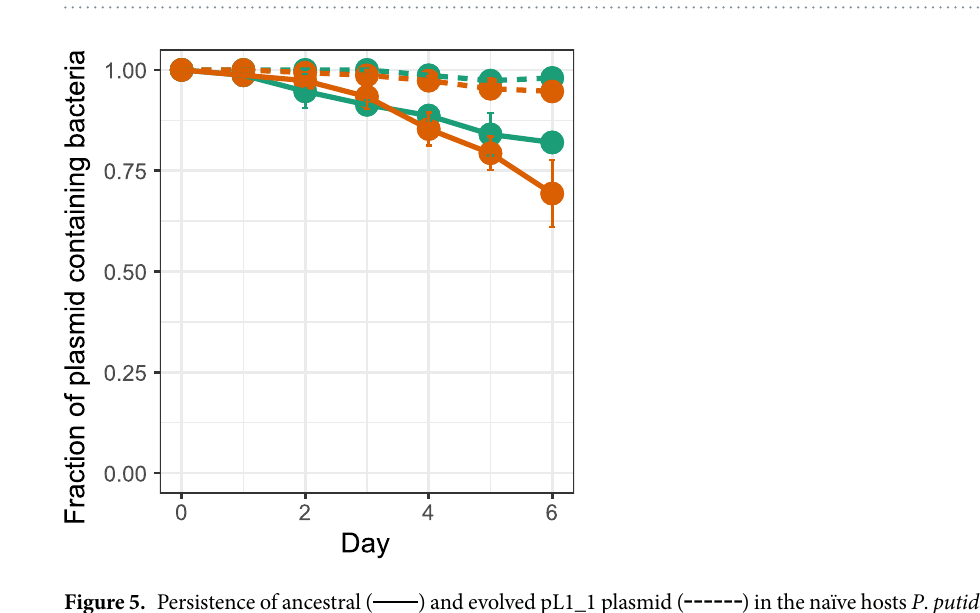
by PCR amplification across the putative transposon-plasmid junctions, followed by sequencing of the amplicons (Fig. S1 and Table S2, SI). The boundaries of the transposon were different than those of the NCBI sequence and suggested that the transposon is present as a single copy on each of the two circular replicons (Table S3, SI). For all these reasons we propose that the large plasmid sequence reported in the MR-1 Genbank sequence is in fact incorrect and should be split into two independent replicons of 142,357 bp and 19,256 bp, each containing a copy of Tn 3 family transposon Tn 6374 that transposed into our plasmid pBP136Km.